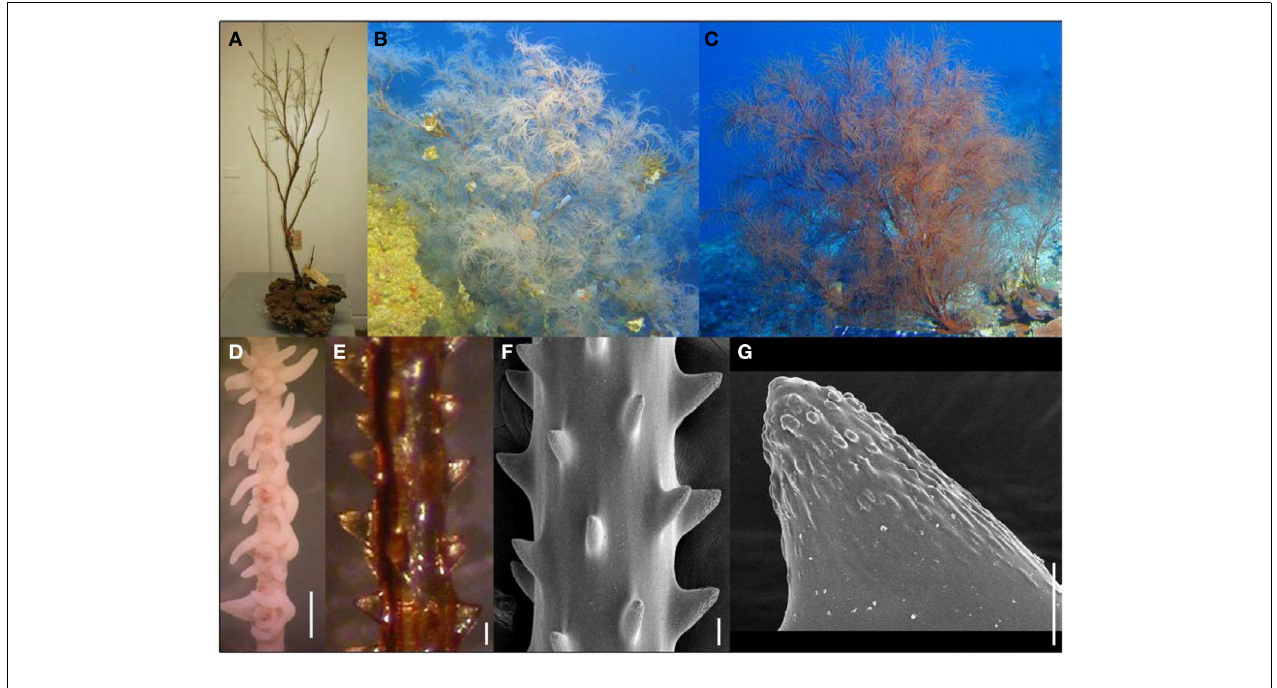
FIGURE 2 | (A) Antipathes grandis holotype (BPBM 102); (B,C) colonies of A. grandis in situ ; (D) preserved polyps on terminal branch under light microscopy (scale bar = 1mm); (E) skeletal spines on terminal branch under